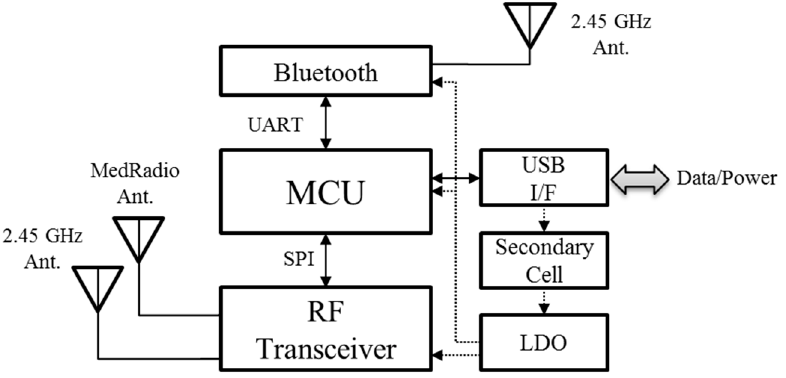
Figure 22. Block diagram of the basestation.